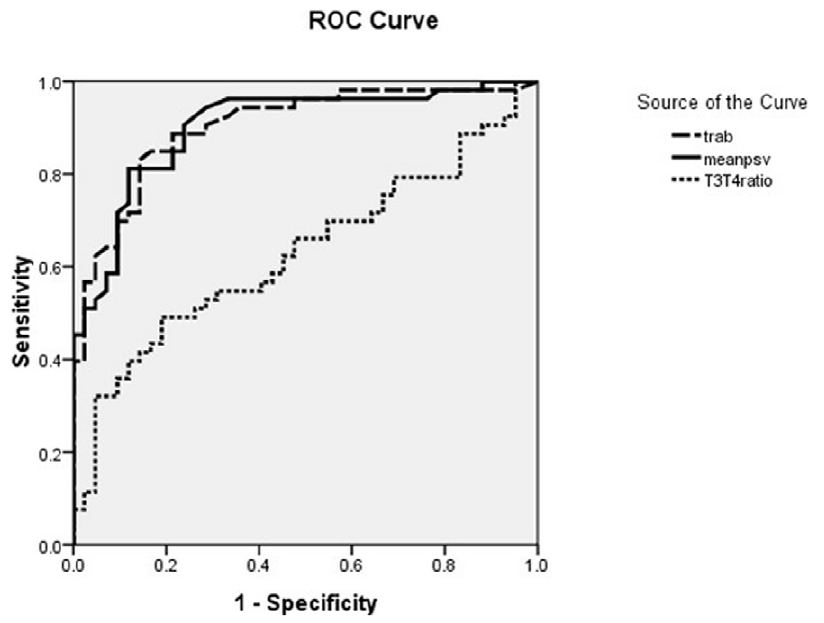
Figure 3. Capacity for the differentiation of thyrotoxicosis: TRAb, FT3/FT4, and mean STA-PSV. doi:10.1371/journal.pone.0050051.g003 PLOS ONE |